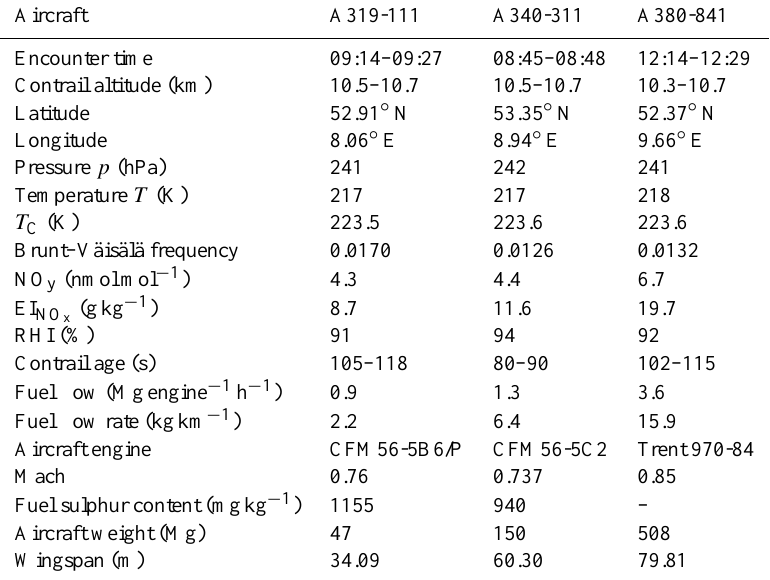
Table 1. Conditions for a subset of observations selected to investigate the impact of the aircraft type on contrail properties. Encounter time and contrail altitude are given for the complete contrail encounters; the other values correspond to the selected contrail sequences. The latitude and longitude are given for the central time of observation. Pressure, temperature, reactive nitrogen (NO y ) mixing ratio and relative humidity with respect to ice (RHI) have been measured on board the Falcon. The threshold temperature for contrail formation is calculated for an overall propulsion efficiency of 0.3 and the given RHI. The fuel flow rate ( m F ) was reported by the pilots of the commercial aircraft. The contrail age and NO x emission index (NO x = NO + NO 2 ) have been calculated as detailed in the text. The fuel sulphur content has been measured for the A319 and A340